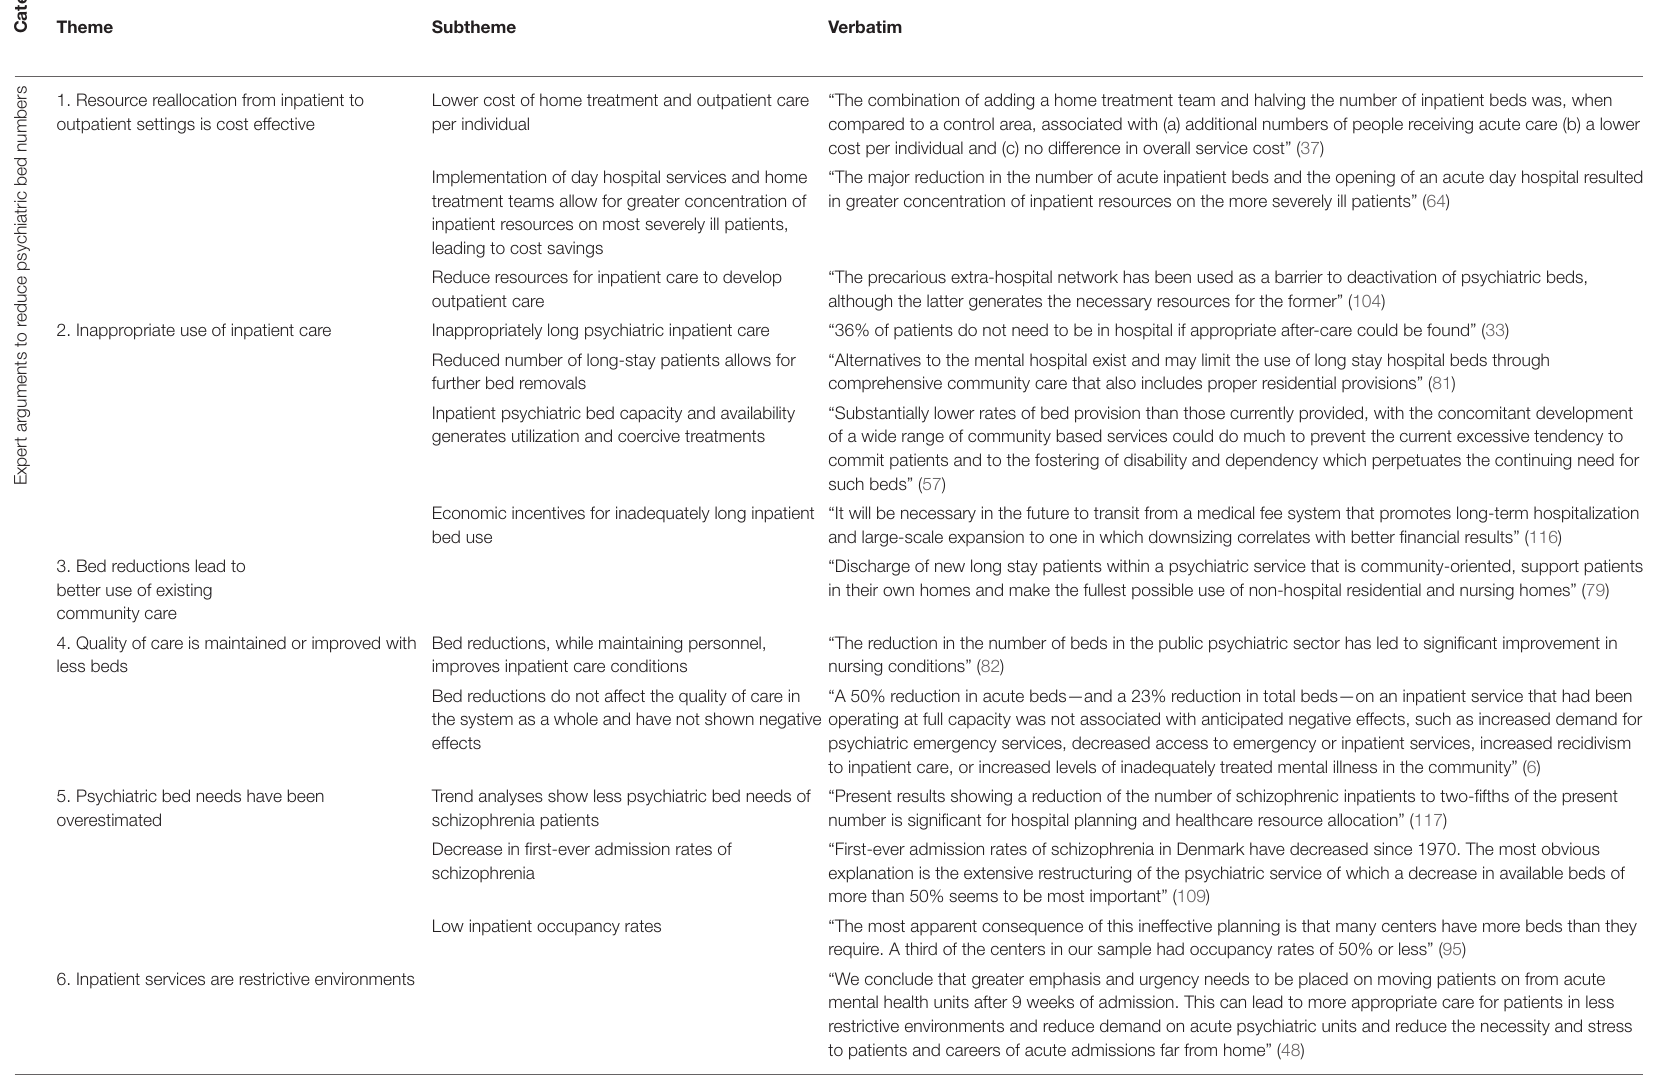
TABLE 3 | Expert arguments for trends of psychiatric bed numbers: themes, subthemes and